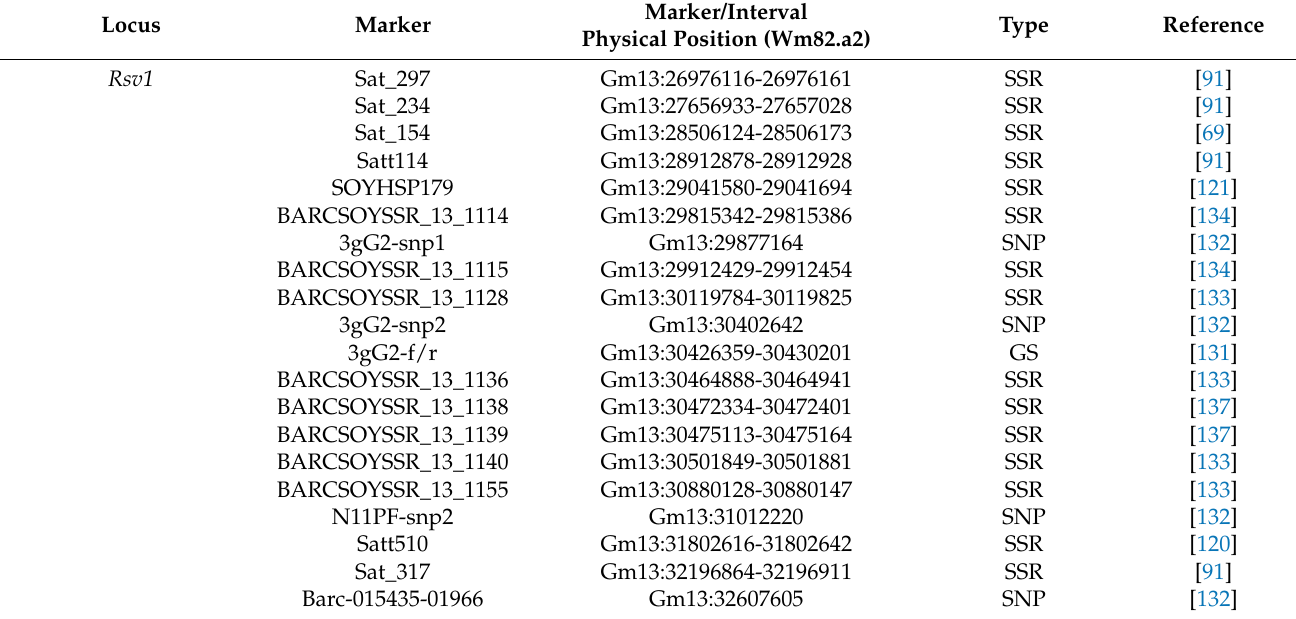
Table 2. PCR-based markers and their positions in relation to SMV resistance loci. Marker/Interval Locus Marker Physical Position